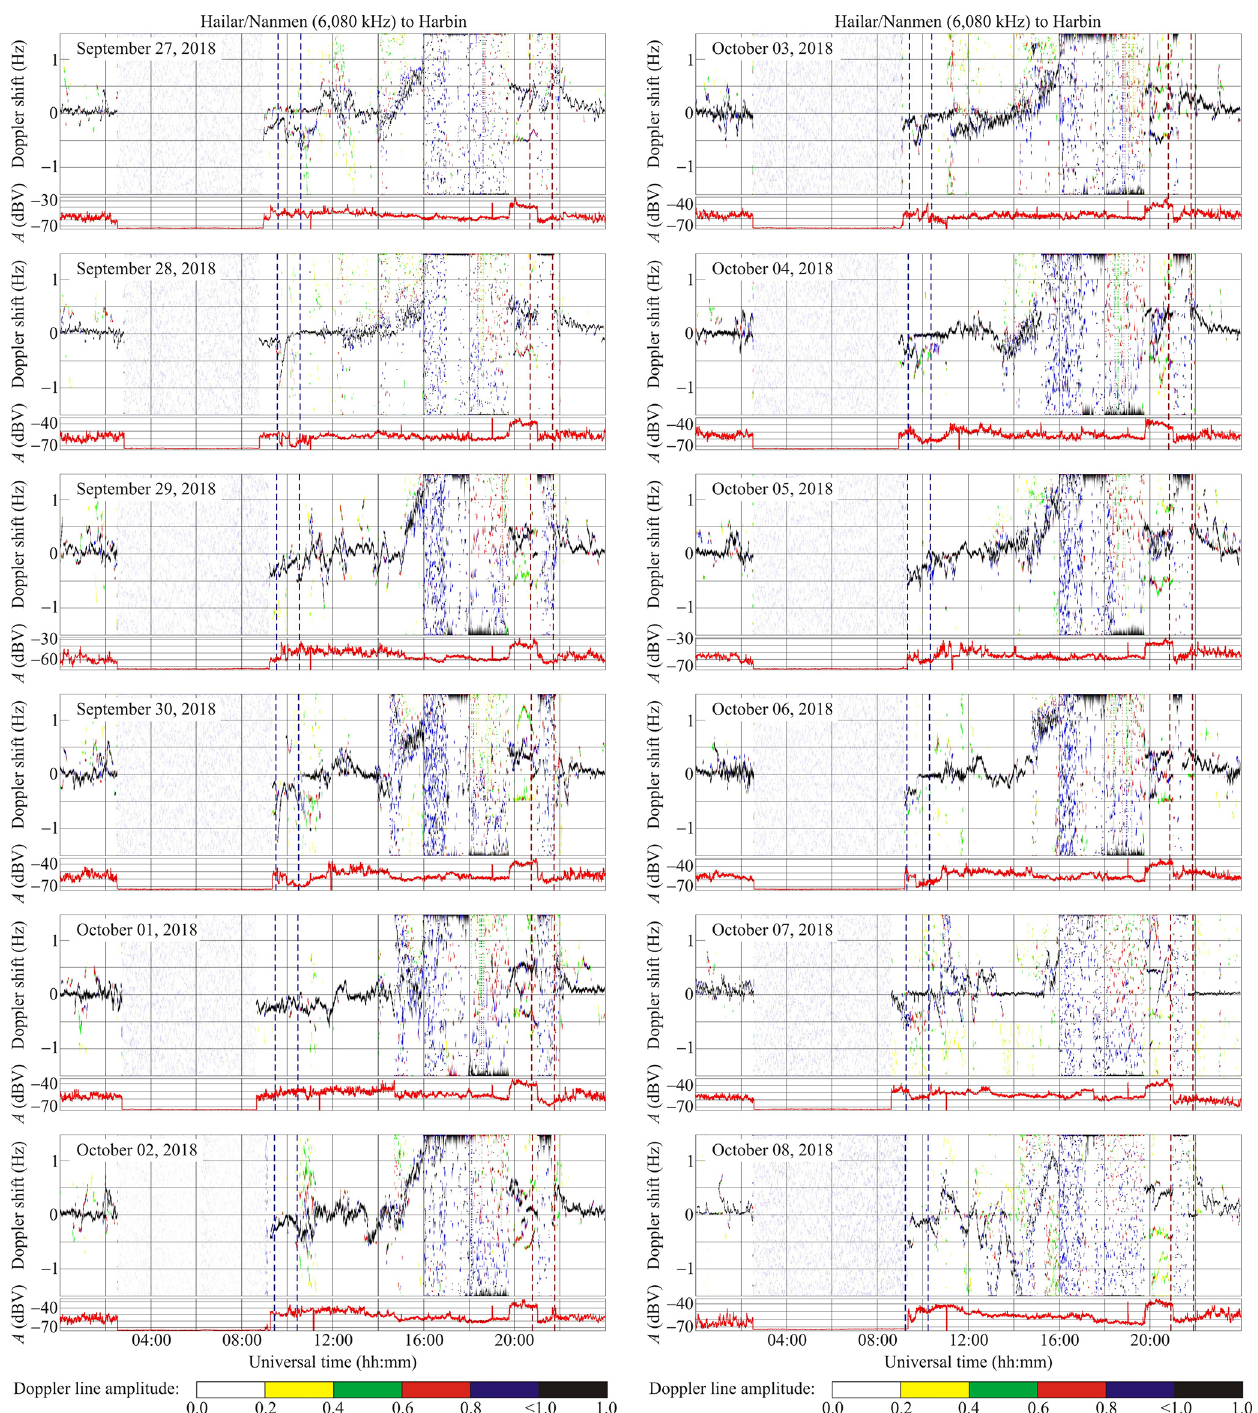
Figure 8. Same as in Fig. 6 but for the Hailar/Nanmen to Harbin radio-wave propagation path at 6080kHz for the 27 September–2 October and 3–8 October 2018